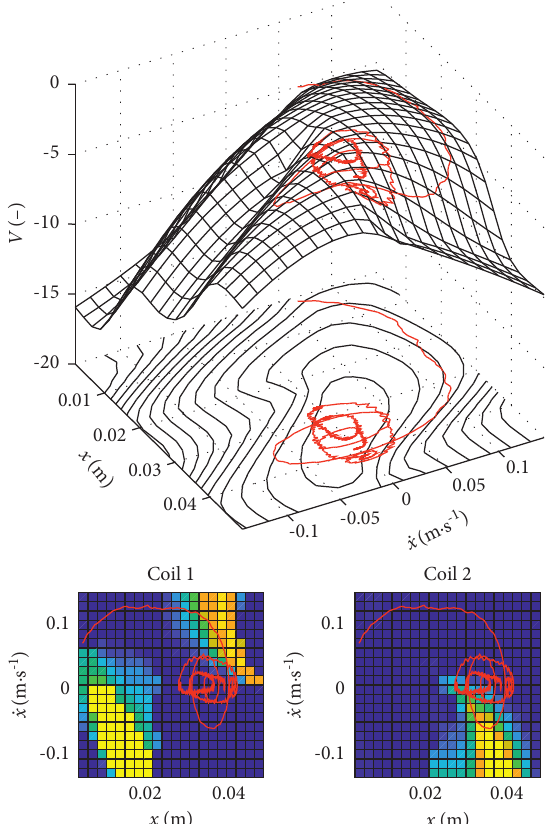
Figure 9: Example of the control sequence trajectory plotted over the policy and the value function based on the model SNGP 10.